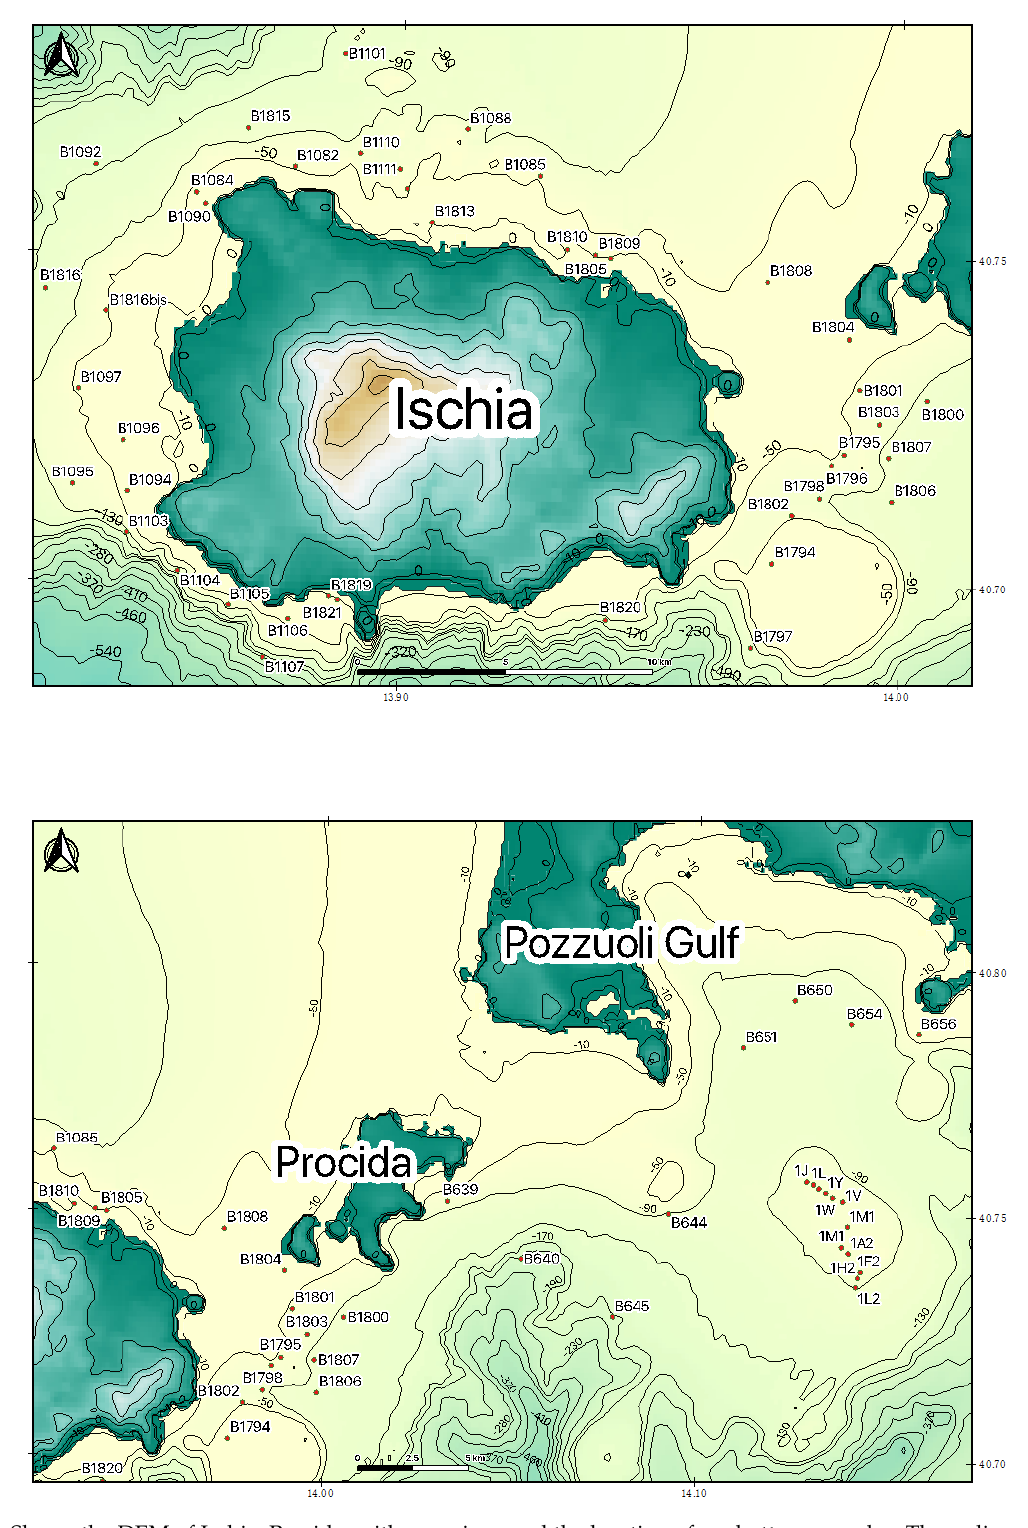
Figure 4. Shows the DEM of Ischia–Procida, with superimposed the location of sea bottom samples. The sedimentological data have been plotted into ternary diagrams. While we can refer to the previous study for the Ischia samples and their elaboration [37], at Procida–Pozzuoli, the samples have been plotted by dividing them into two groups, from sample B1A2 to sample B1054 (Figure 6a,c) and from sample BXMIS1 to sample PM27 (Figure